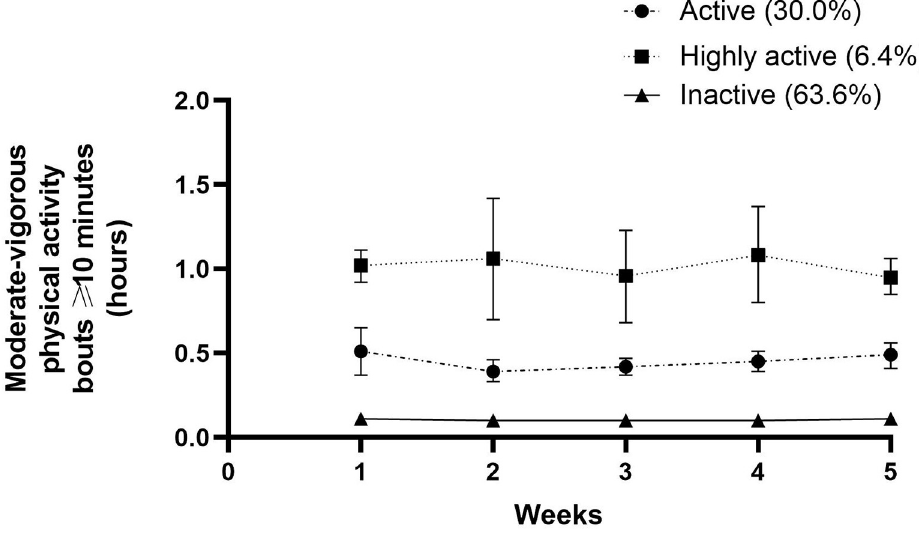
Fig 4. Moderate to vigorous physical activity bouts ( � 10 minutes) in hours per day between three weeks and eight weeks after discharge from the hospital in stroke